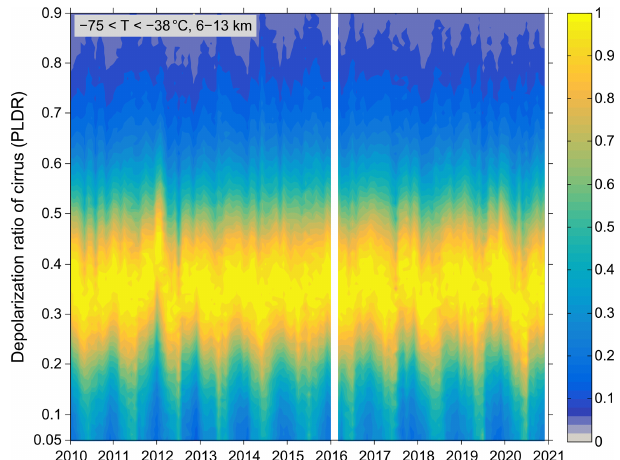
Figure 3. Number densities of the cirrus PLDR distribution nor- malized for each month from January 2010 to December 2020. The data are derived from the observations at the typical cirrus heights from 6 to 13km and at temperatures between − 75 and − 38 ◦ C. The colour codes are used to visualize the relative number densities of scatter point data, with the maximum number density indicated by 1 in the colour